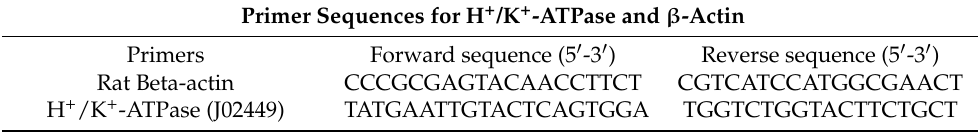
Table 1. Forward and reverse primer sequences. Primer Sequences for H + /K + -ATPase and β